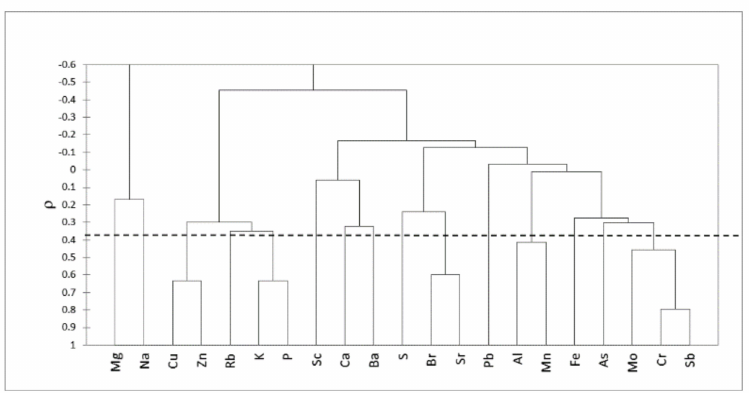
Figure 2. Cluster analysis dendrogram for 39 samples and 21 elements. Cluster analysis was based on Spearman’s rank correlation ρ